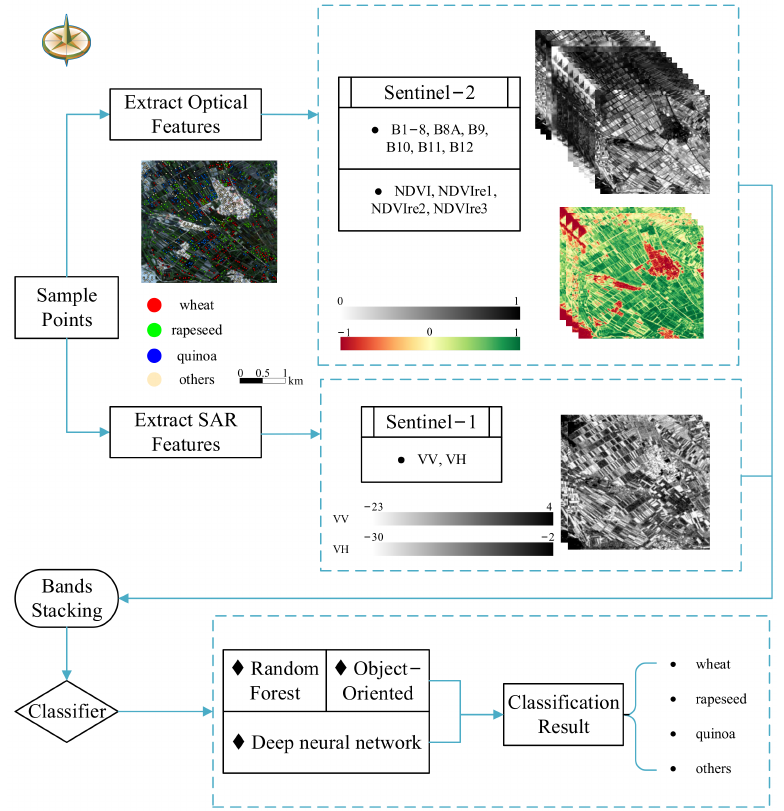
Figure 5. Technical route map. The GEE represents the Google Earth Engine platform and the Colab represents the Google Colaboratory platform in the